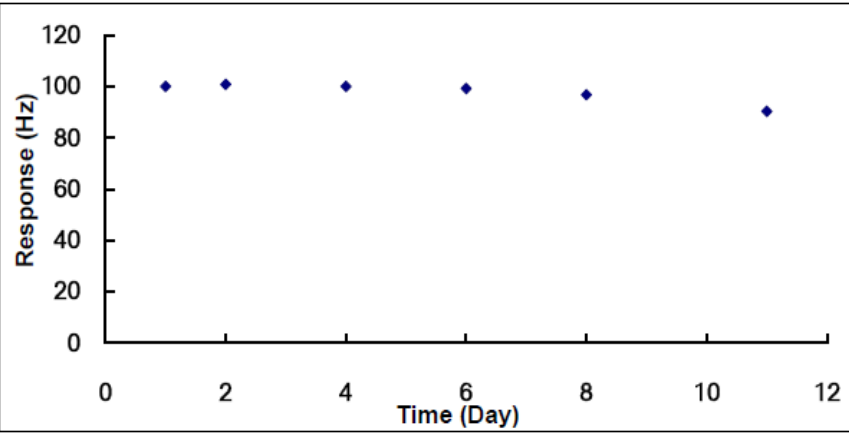
/MnO composite film based QCM sensor to a 2 2